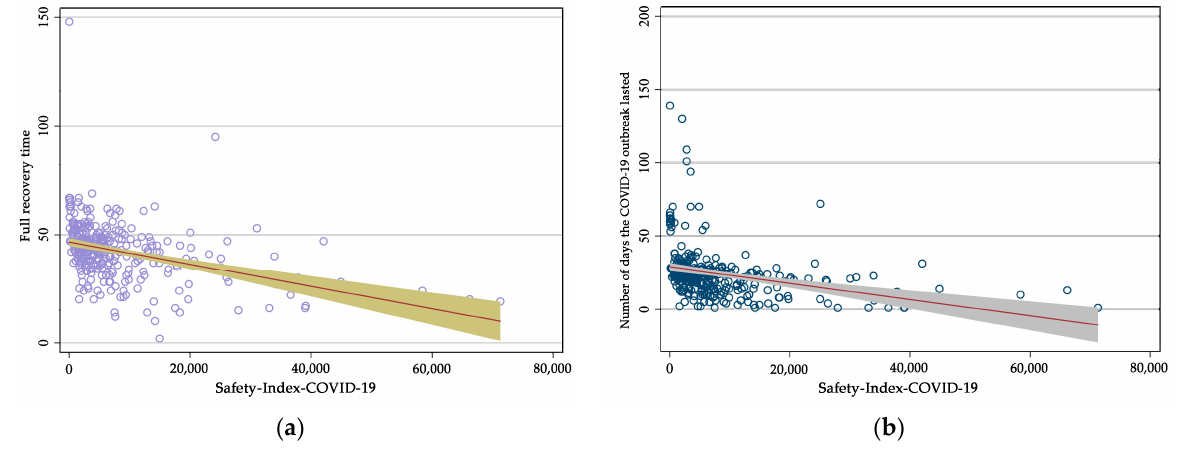
Figure 8. Correlation diagrams: ( a ) the correlation analysis of the COVID-19 safety index with the number of full recovery days; ( b ) the correlation analysis of the COVID-19 safety index with the number of days the outbreak lasted. Table 5. Correlation analysis between the COVID-19 safety index and the actual performance index scores of the epidemic in 333 cities.